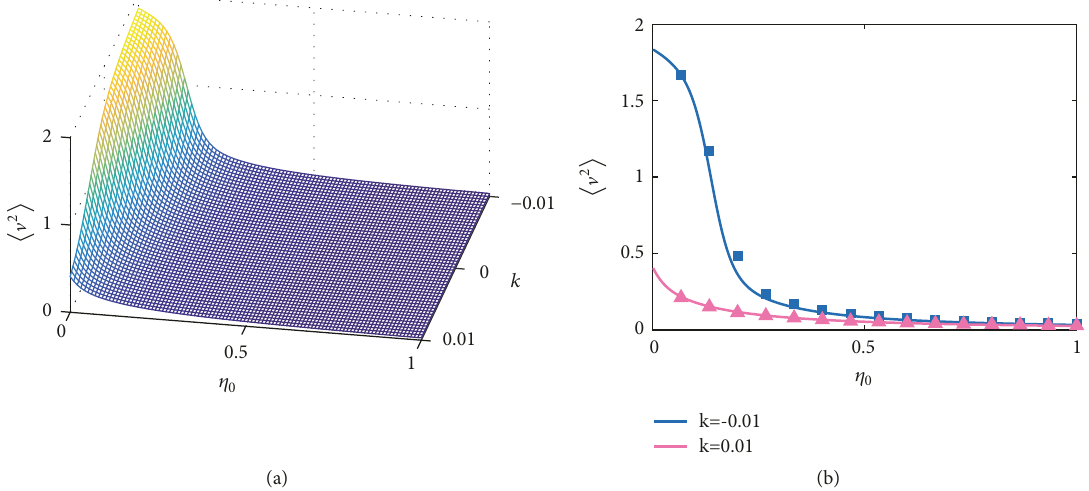
Figure 12: The dependence of the mean square electric voltage ⟨ V 2 ⟩ on 𝑘 and 𝜂 0 . Solid lines are the analytical results; symbols result from numerical simulations.